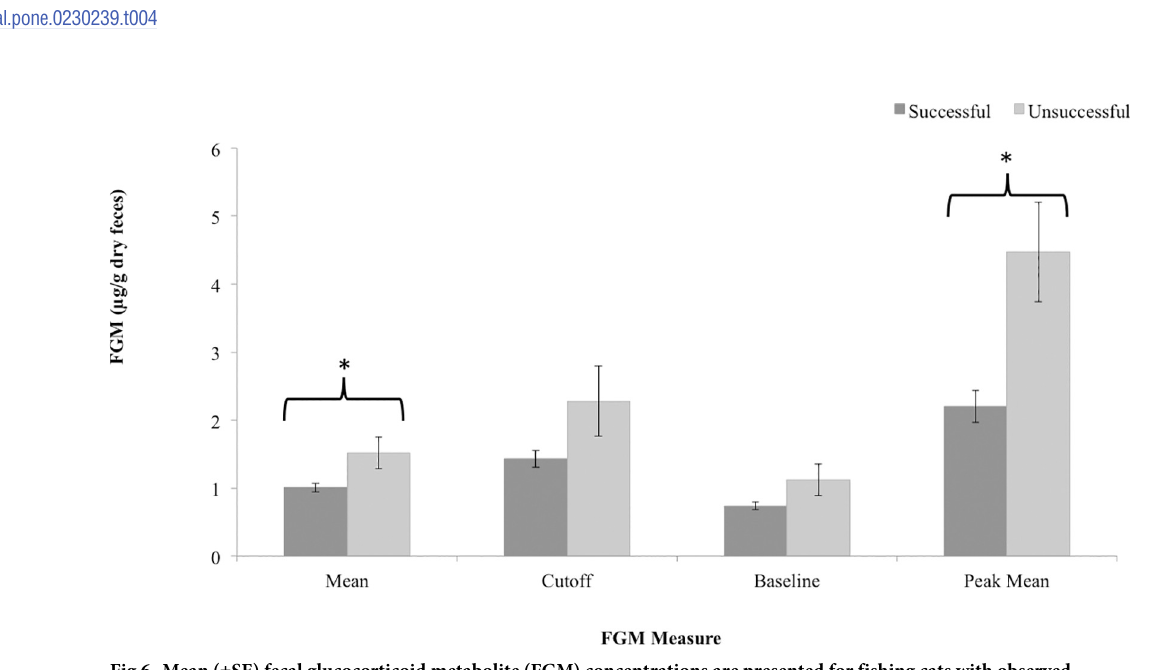
Fig 6. Mean ( ± SE) fecal glucocorticoid metabolite (FGM) concentrations are presented for fishing cats with observed copulations (successful) and those with no observed copulations (unsuccessful). Results of binomial GLMM revealed that both Mean and Peak Mean FGM measures could predict breeding success in fishing